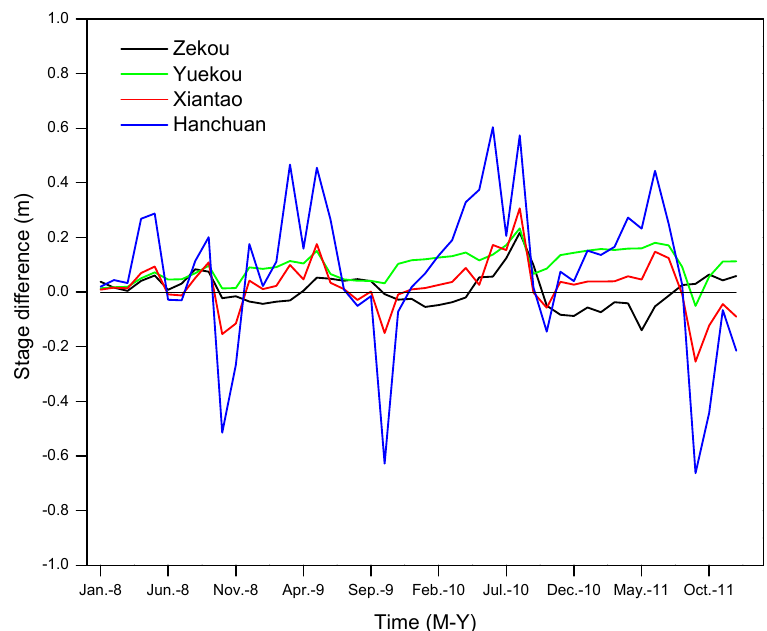
Figure 5. Monthly average stage differences at the gauging stations in the lower Han River with and without the TGR operation from January 2008 to December 2011. The positive stage difference at the gauging stations indicates the natural stage without the TGR is lower than the one under the flow regulation of the TGR and vice versa.